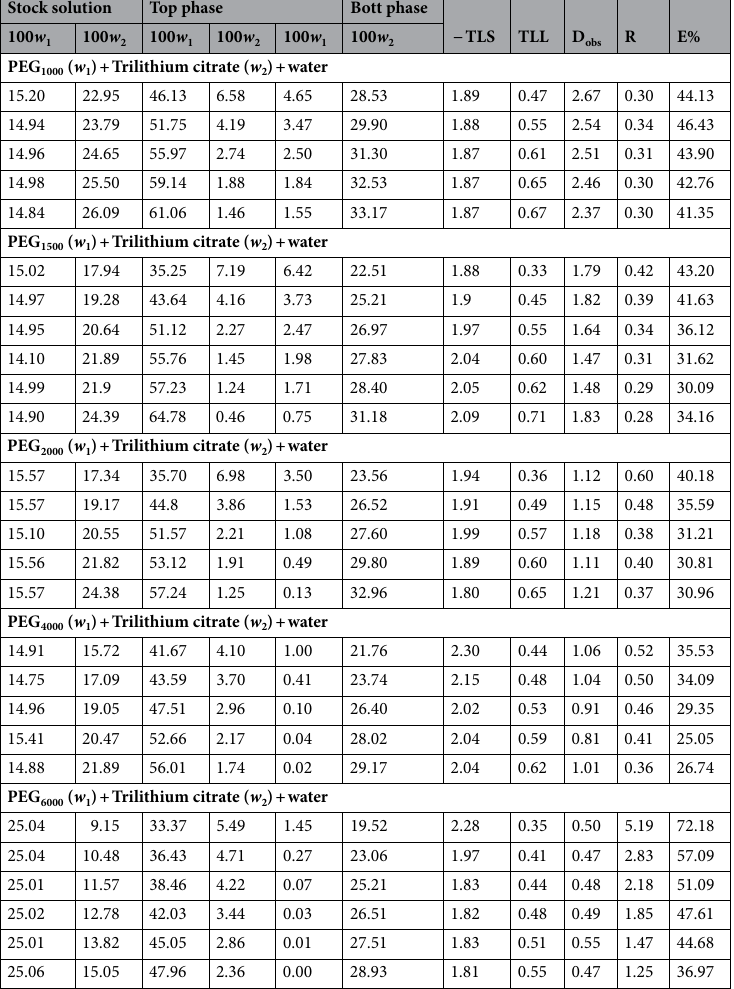
Table 3. Experimental tie-line mass factions ( w ) for PEG 1000,1500,2000,4000,6000 (1) + trilithium citrate (2) + water (3) system at T = 298.15 K, and P = 101 KP, along with the tie-line length (TLL), and tie-line slop (TLS). The measured partitioning coefficient ( D obs ), the extraction efficiency percent ( E %), and the separation coefficient ( R ) of the salbutamol in the studied tie-lines were also reported. Standard uncertainties, u, are u( T ) = 0.1 K, u( w ) = 0.0013, and u( P ) = 5